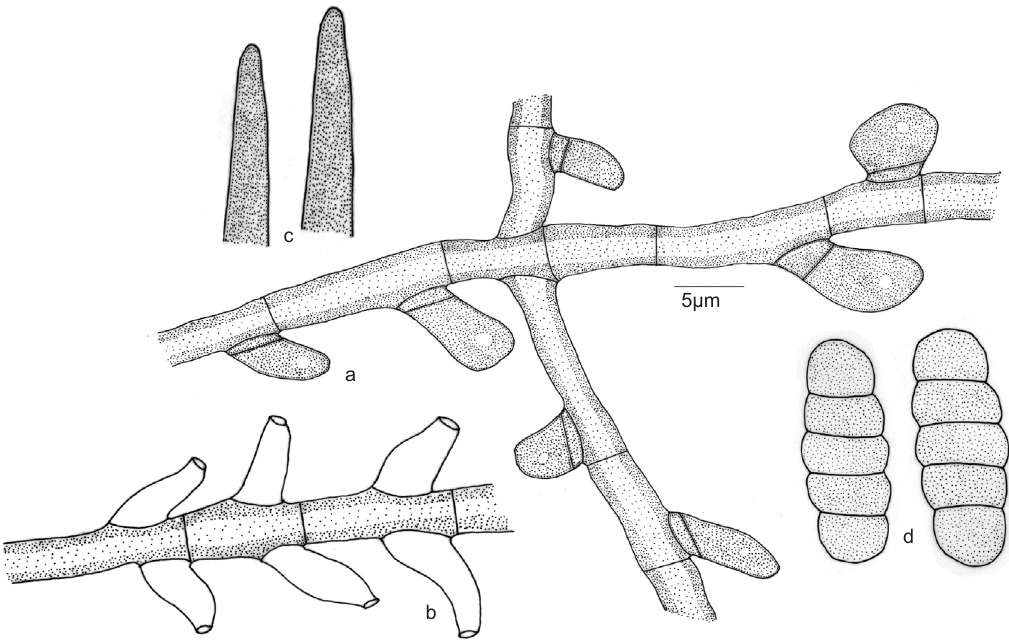
Figure 2. Meliola sterculicola sp. nov. a - Appressorium; b - Phialide; c - Apical portion of the mycelial setae; d -